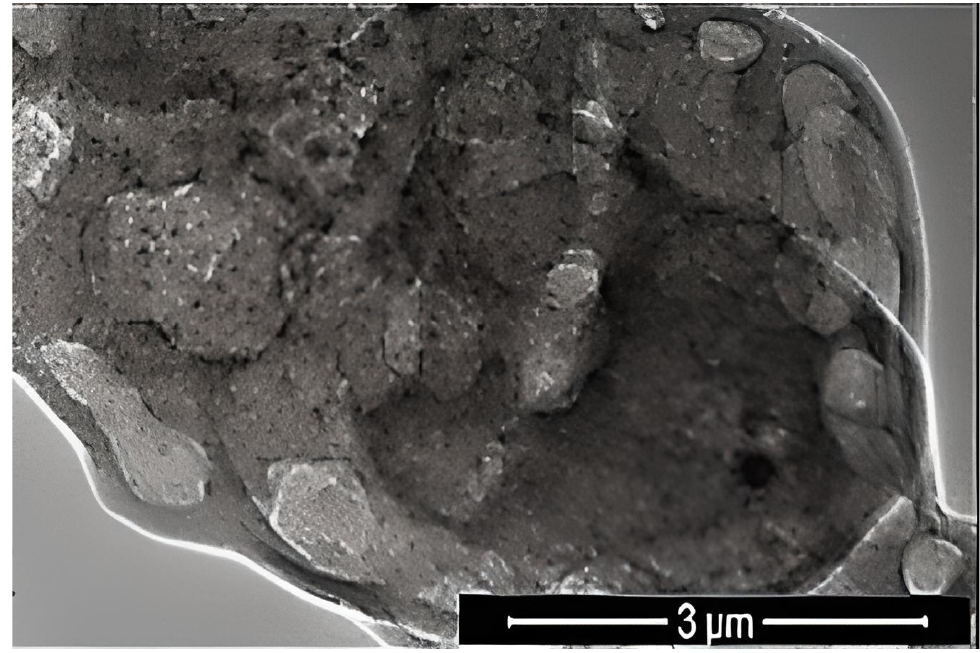
Figure 3. Transmission electron microscope (JEOL JEM-ARM200CFEG UHR-TEM, illustration taken as a scale of 3 μ m) image of Co 2 B NPs.